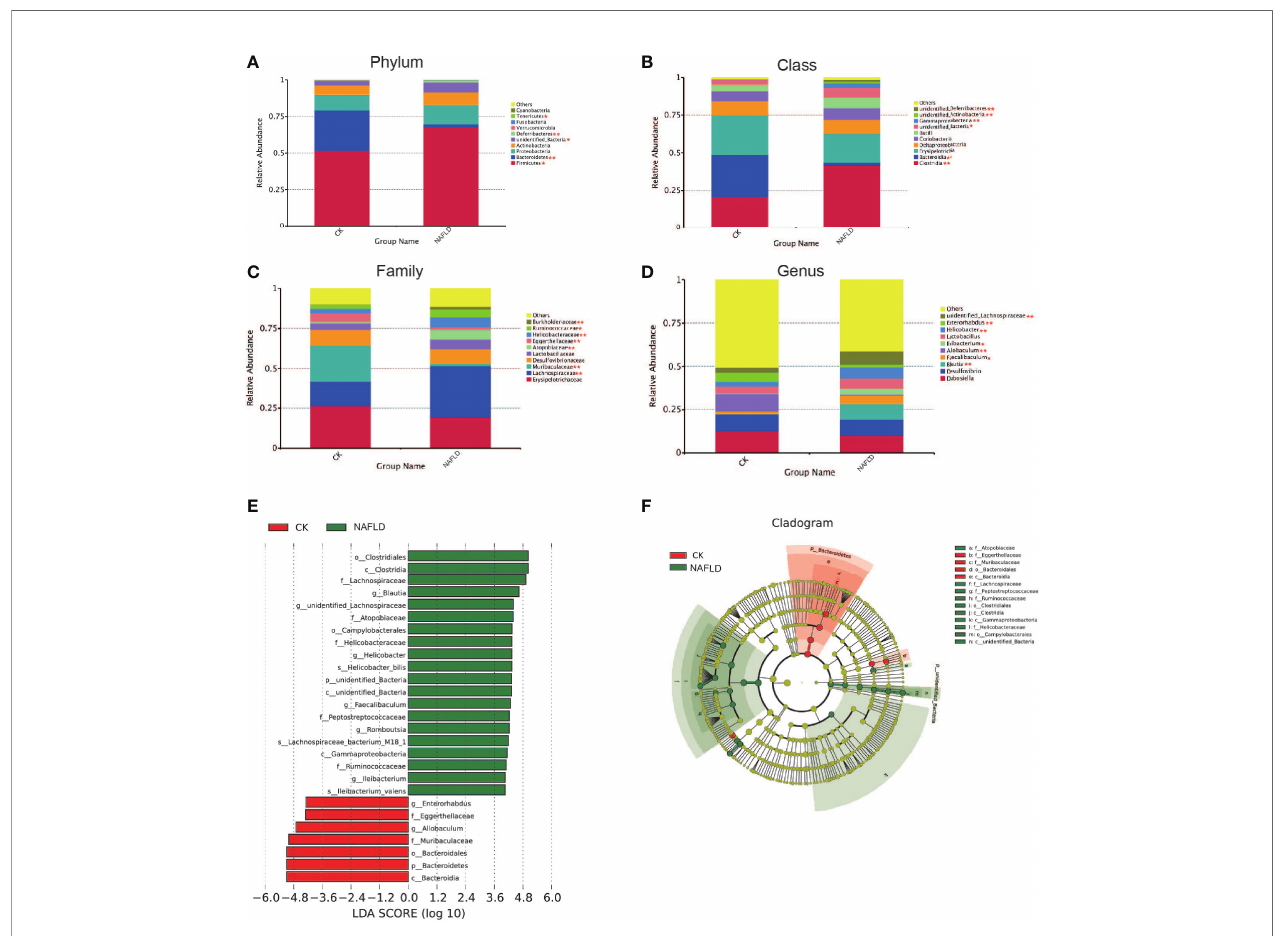
FIGURE 4 | The distribution and composition of the bacterial community at each classi fi cation level. (A-D) Cecal bacterial pro fi les at the Phylum, Class, Family and Genus levels displaying relative abundance of the partial cecal microbiota. (E) Functional biomarkers found by linear discriminant analysis effect size (LEfSe); (F) Functional cladogram obtained from LEfSe. “ * ” indicated p-value < 0.05, “ ** ” indicated p-value < 0.01 (Wilcox Rank-Sum